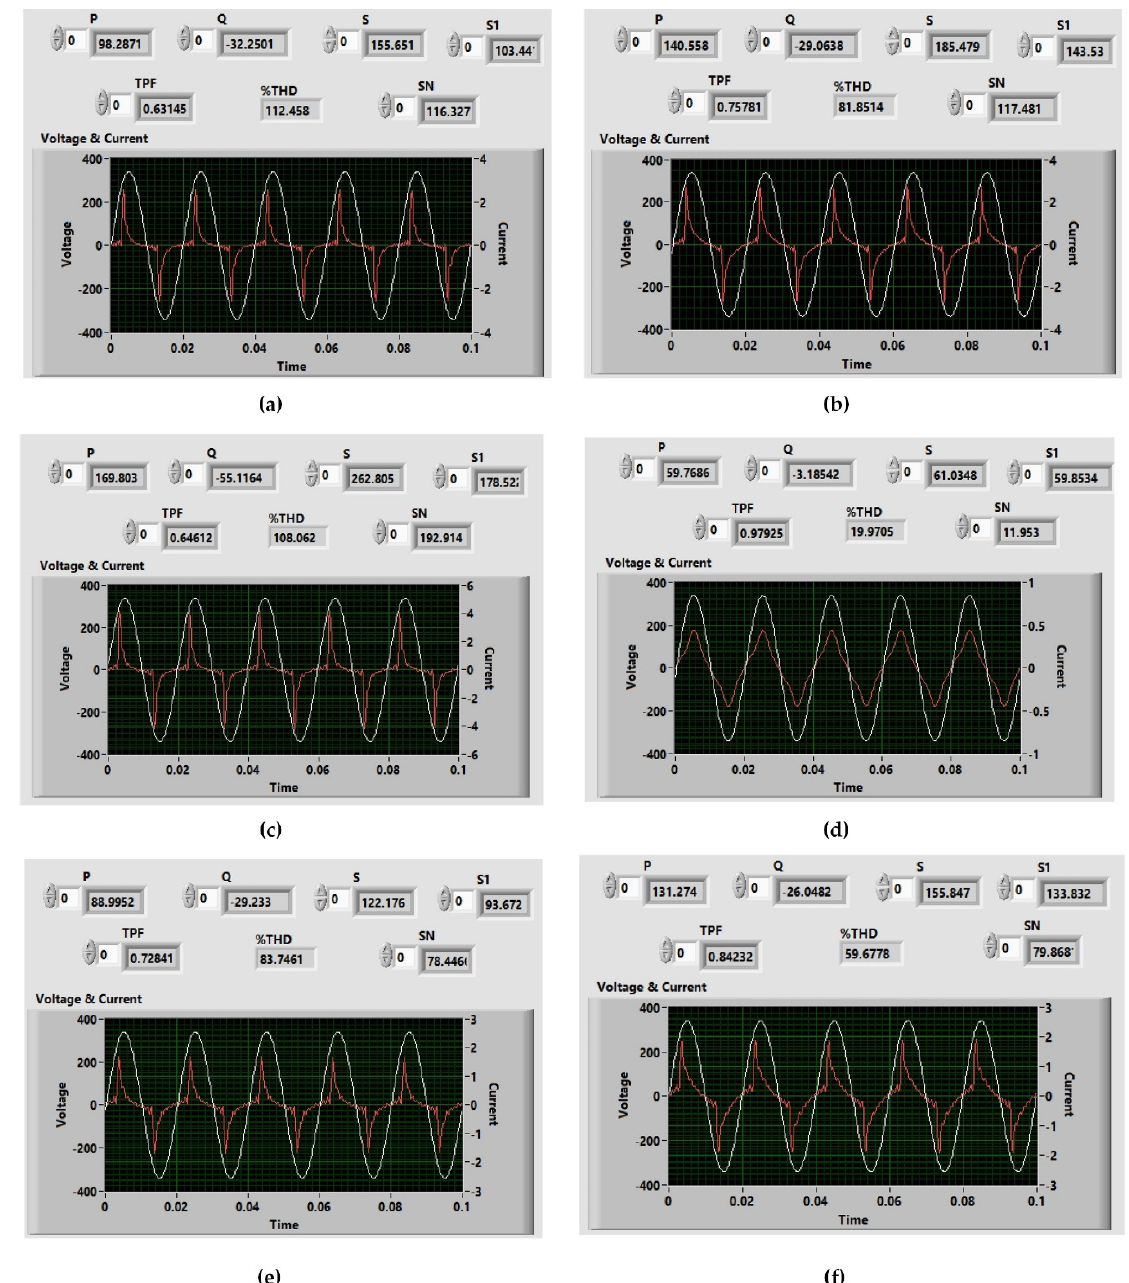
Figure 6. The voltage and current waveforms of combinations of two real-world appliances: ( a ) CFL and LED; ( b ) CFL and exhaust fan; ( c ) CFL and SMPS of a PC; ( d ) LED and exhaust fan; ( e ) LED and SMPS of a PC; ( f ) exhaust fan and SMPS of a PC.